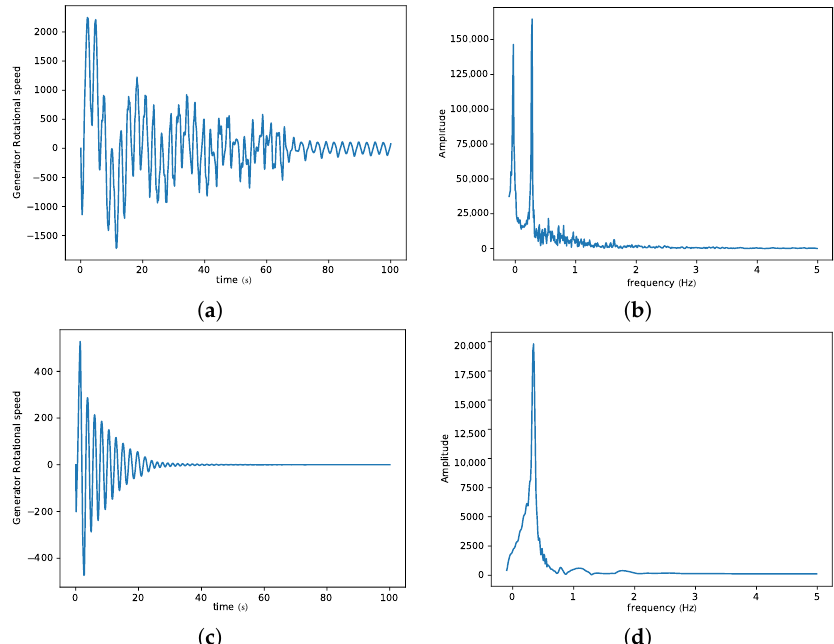
Figure 6. A plot of generator rotational speed ( ˙ θ 4 ) vs. time (t) to study the effect of higher damping and torsional stiffness. ( a , b ) are the time series and the corresponding FFT frequency spectrum plots for low damping and torsional stiffness at K l = 1.0, K h = 0.01, K 2 = K 3 = 0.005, C l = 0.05, C h = 0.009, C 2 = C 3 = 0.01, C m = 0.001, D t = 0.01, D g = 0.009 and β = π /6. In ( c , d ), the damping and torsional terms have been increased by a factor of 10. The remaining parameters are fixed and presented in Table